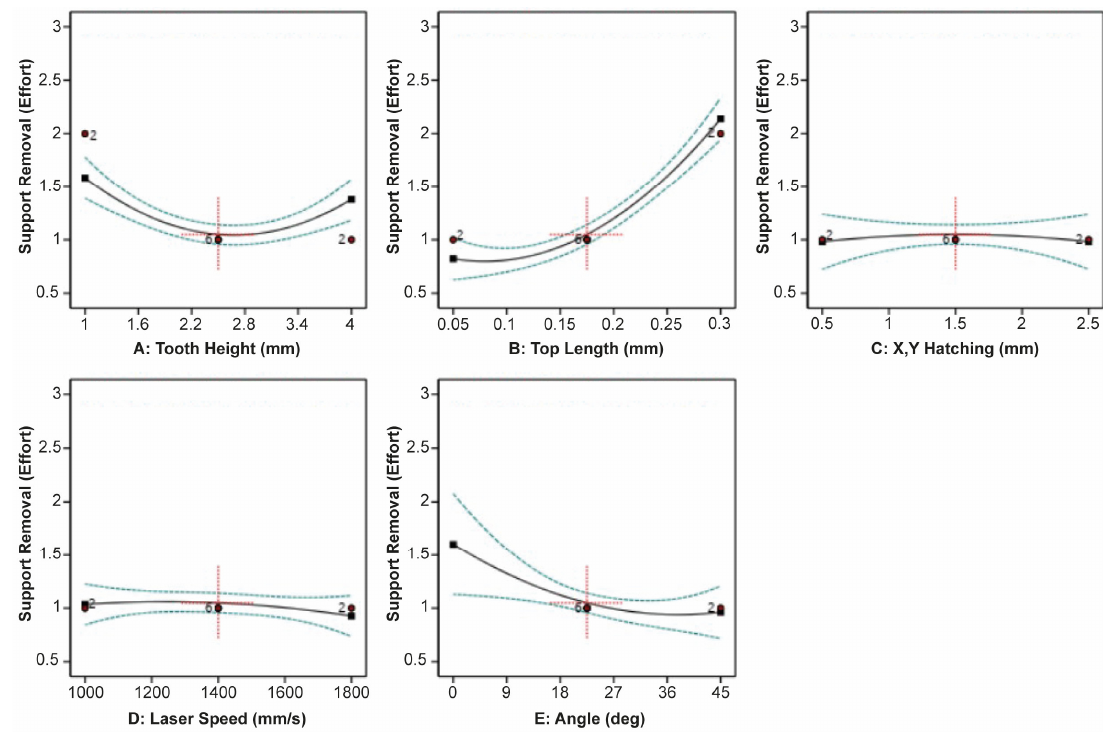
Figure 8. Main plots of Support Removal Effort in Design-Expert 13.